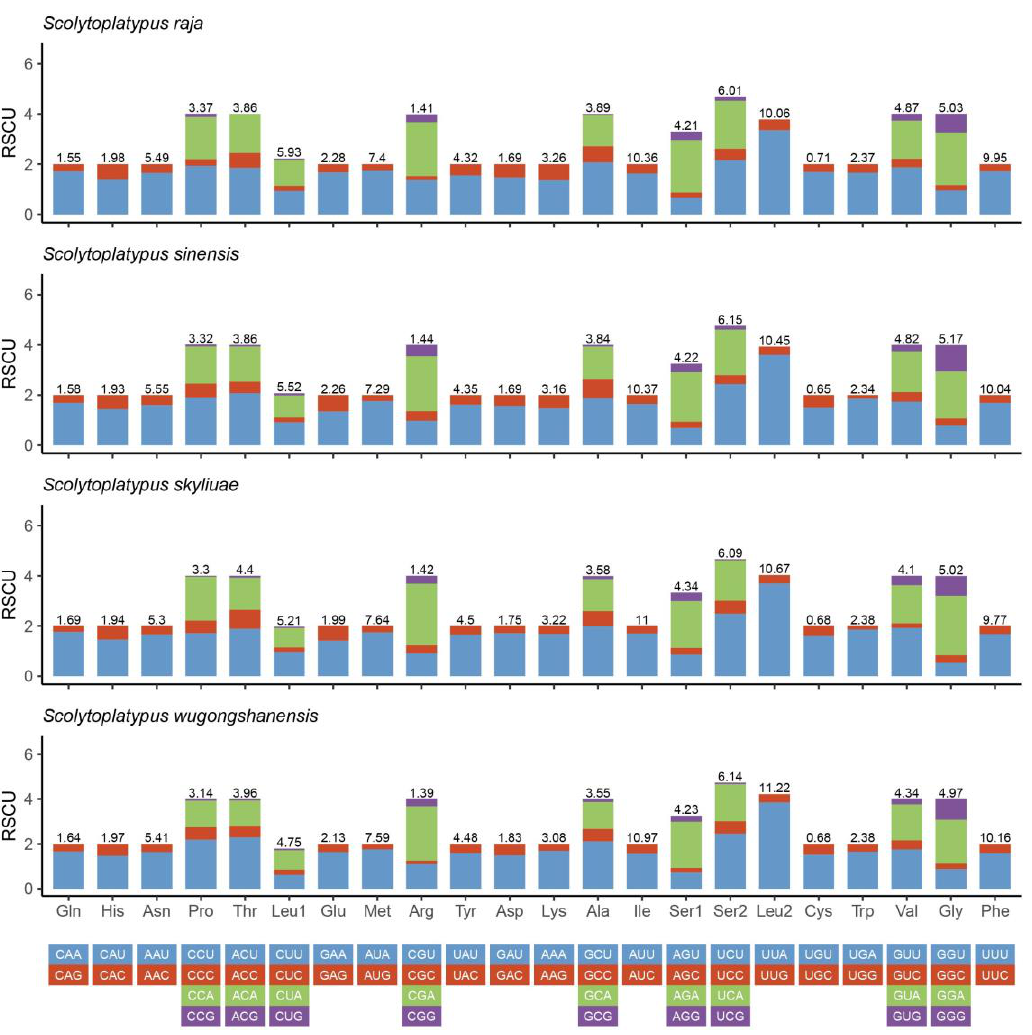
Figure 2. Relative synonymous codon usage (RSCU) of four Scolytoplatypus species. The ordinate represents the RSCU (the number of times a certain synonymous codon is used/the average number of times that all codons encoding the amino acid are used). The abscissa represents different amino acids. The number above the bar graph represents the ratio of amino acids (number of certain amino acids/total number of all amino acids).